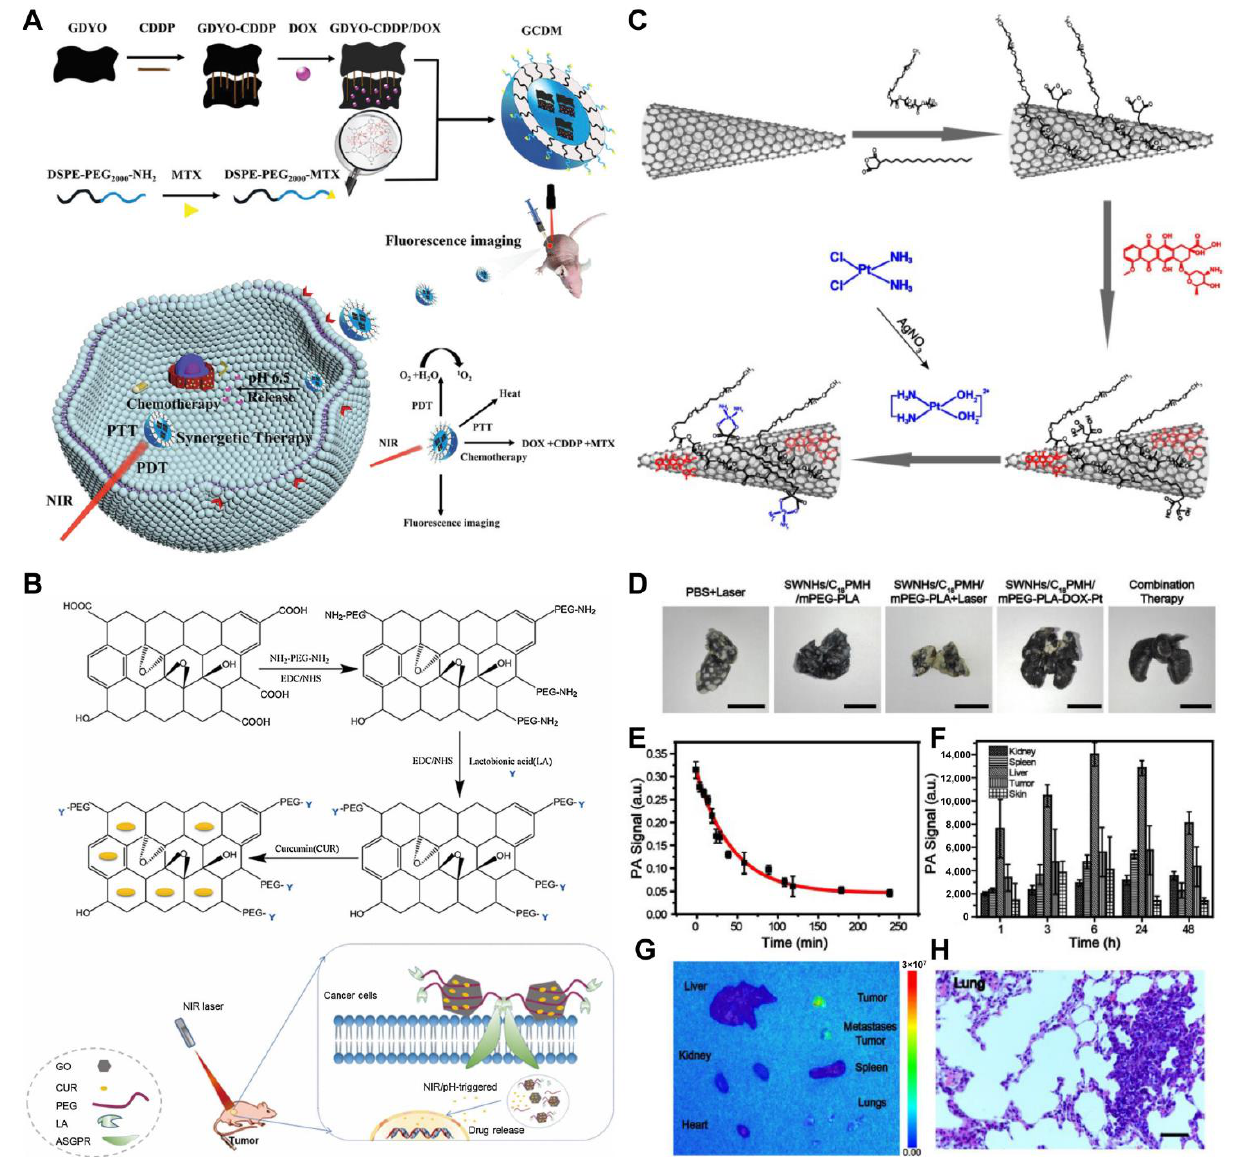
Figure 3. Preparation of high drug-loading nanomedicines from carbon nanomaterials for combined chemotherapy-photothermal treatment of tumors. ( A ) Schematic illustration for the preparation of GCDM [33]. ( B ) The preparation of GO-PEG/LA-CUR nanocomposites [64]. ( C ) Schematic illustration of the preparation of dual drug-loaded SWNHs. ( D ) India ink staining of lungs from different treatment groups. Scale bar is 1 cm. ( E ) Blood circulation time and ( F ) bio-distribution of SWNHs/C18PMH/mPEG-PLA-DOX-Pt evaluated by PAI. ( G ) Ex vivo fluorescence images of major organs and tumors 24 h post injection of SWNHs/C18PMH/mPEG-PLA-DOX-Pt. ( H ) HE staining of lung tissues after fluorescence imaging. The metastatic nodules can be clearly observed. Scale bar is 100 μm [37]. Reprinted with permission from Ref. [33]. Copyright 2021, John Wiley & Sons, Inc. Reprinted with permission from Ref. [64]. Copyright 2020, Elsevier.